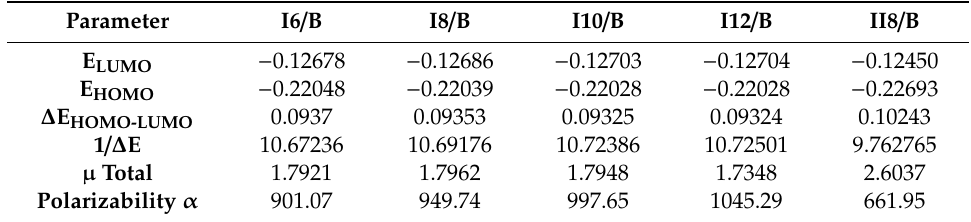
Figure 9. The estimated plots for frontier molecular orbitals of supramolecular In/B complexes. Table 3. FMO Energies a.u., Polarizability, α, and Dipole Moment μ (Debye) of I6/B, I8/B, I10/B, I12/B and II8/B.